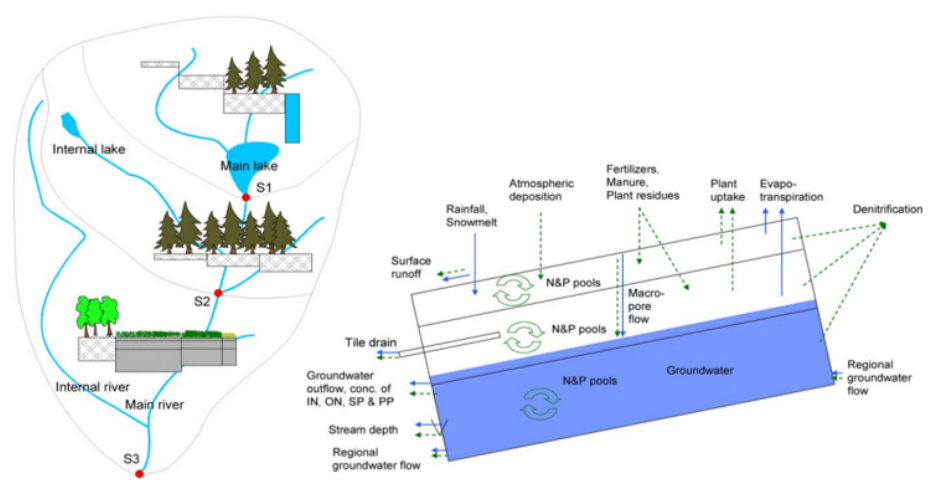
Figure 2. Hype schematic